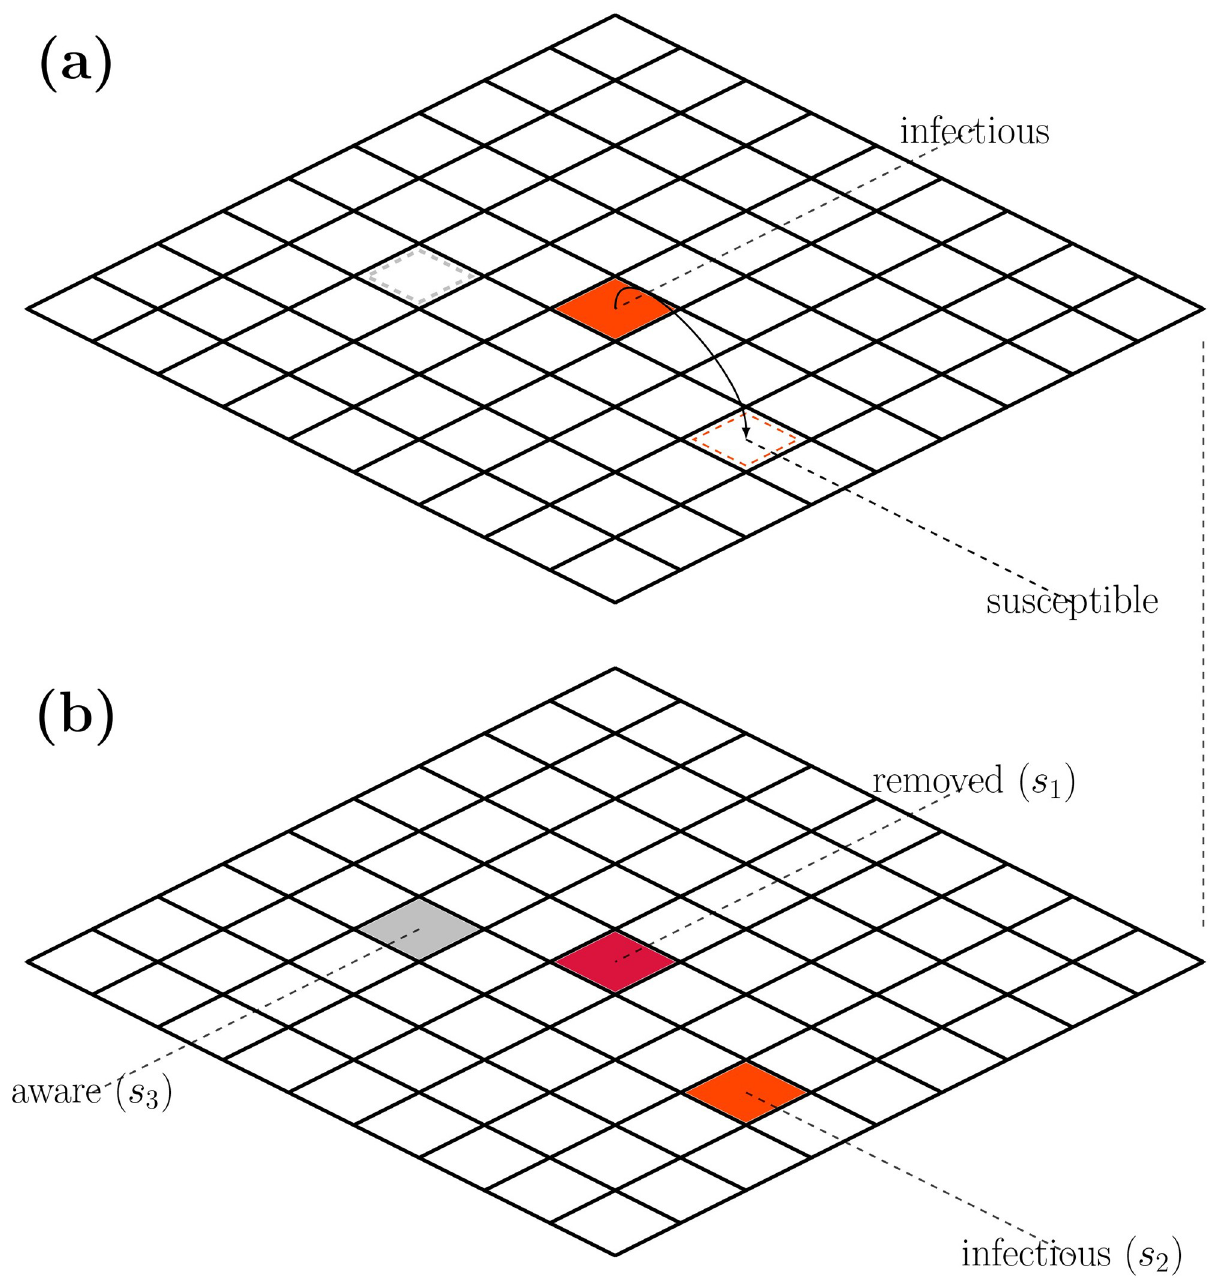
Fig 3. Diagram of the spatial model. Each site on the grid contains just one person. A small grid is with one infectious person in the center. (a) the infected person spreads disease and awareness to nearby squares. The transitions occur with probability β and α , respectively. The infected cell is removed with probability γ . (b) shows the updated